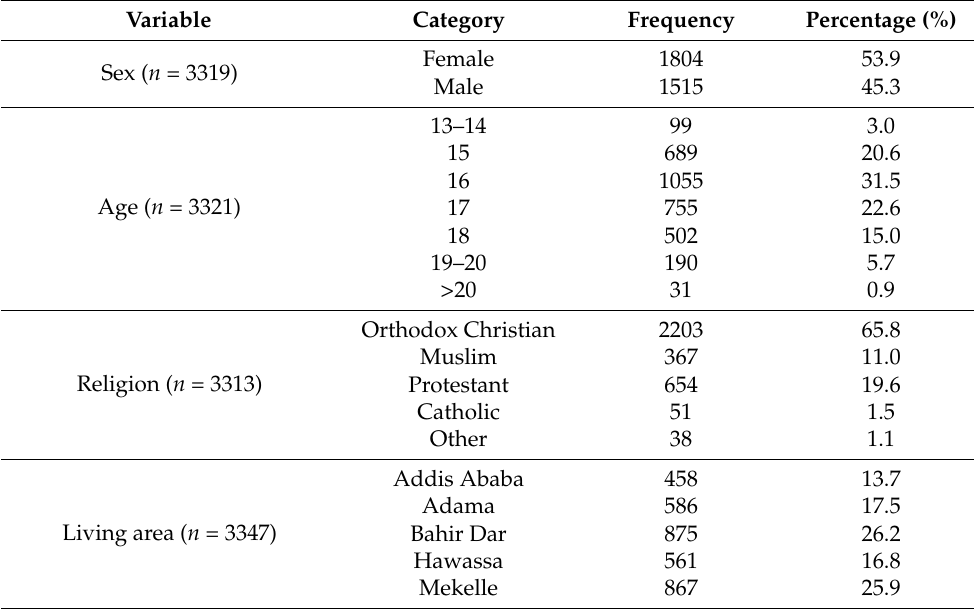
Table 1. Study participants and school level characteristics in Ethiopia (March